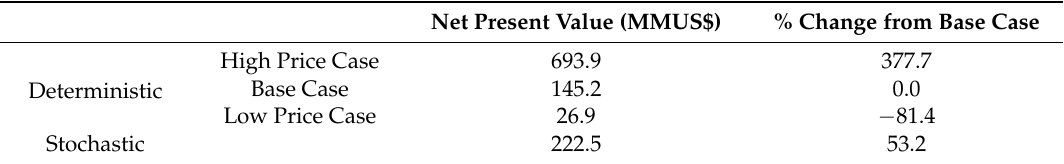
Table 2. Comparison of deterministic and stochastic cases.